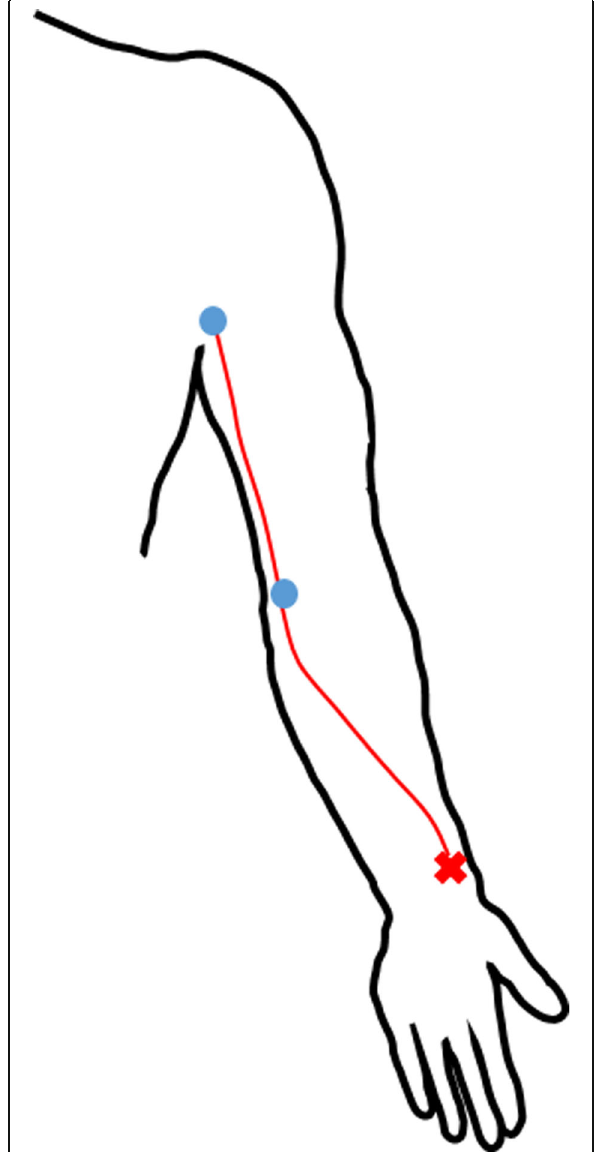
Fig. 4 The red X marks the injection site of the contrast agent. Blue dots demonstrate the location of the enhancing lymph nodes in the antecubital fossa and axilla. The red line illustrates roughly the enhancing superficial lymphatic route seen in all of the successful